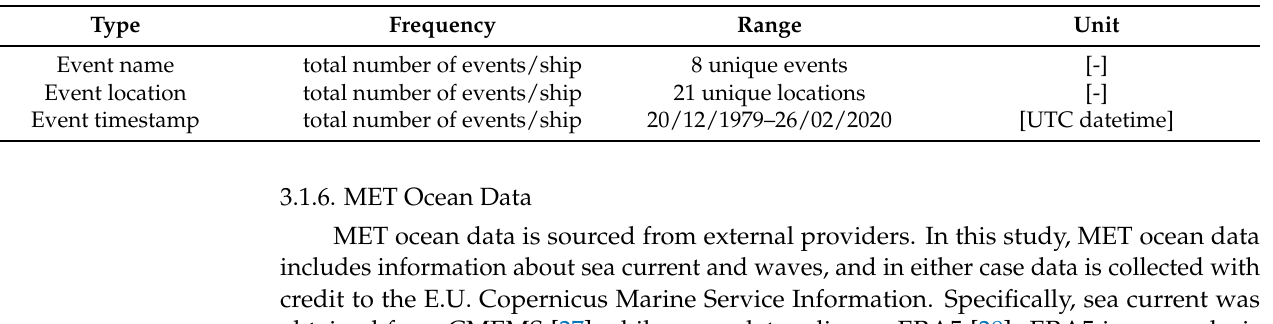
Table 6. Sampling frequency, range and units of cleaning events data.